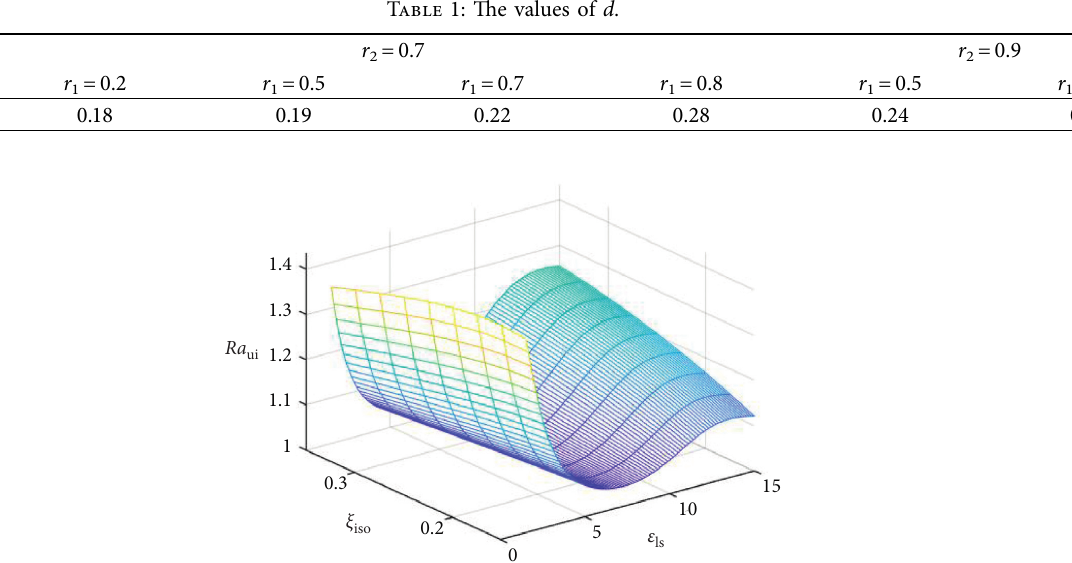
� 0.7, r � 0.9, and ε � 4). 2 us